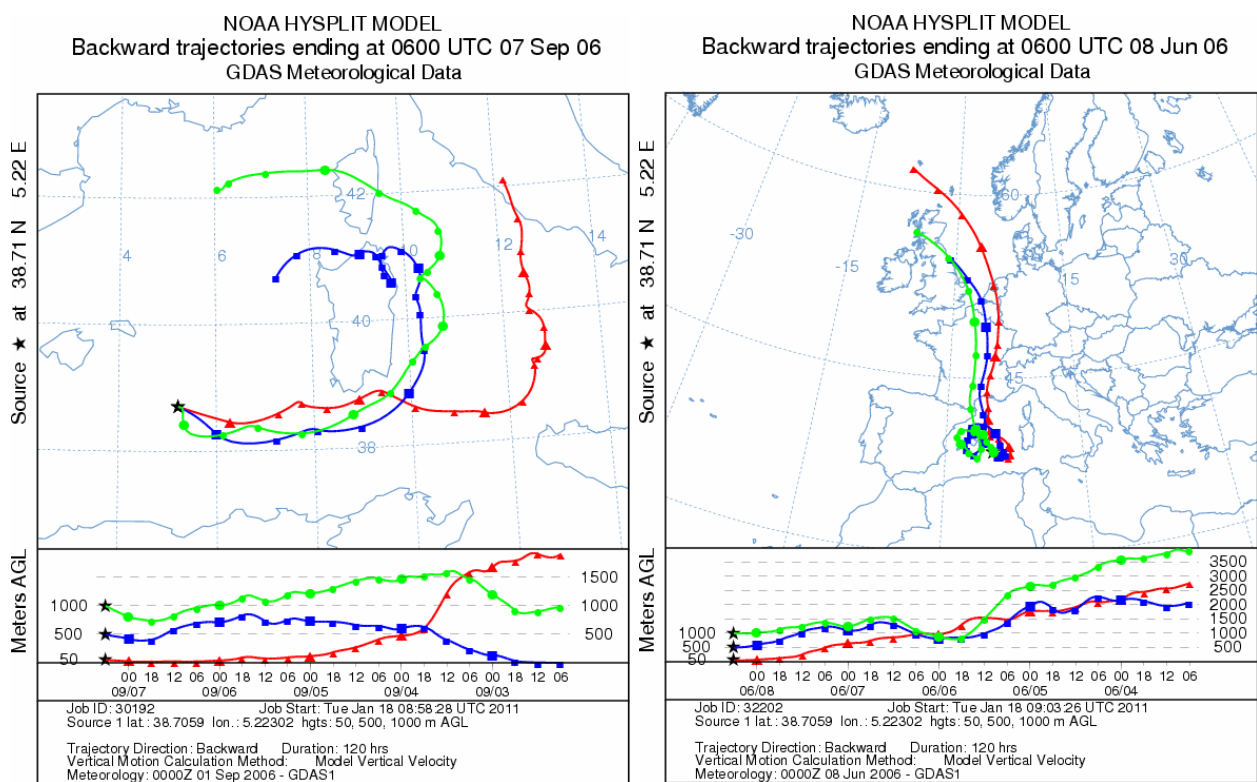
Fig. 9. 5-day back trajectories arriving at Costa Fortuna (track Tunis-Palma de Mallorca) for two typical “High” ozone cases in conditions of: regional summer anticyclone (breeze induced) (left) and synoptic anticyclone (right). Bottom panel: vertical cross sections of the trajectories. Tick marks are placed every